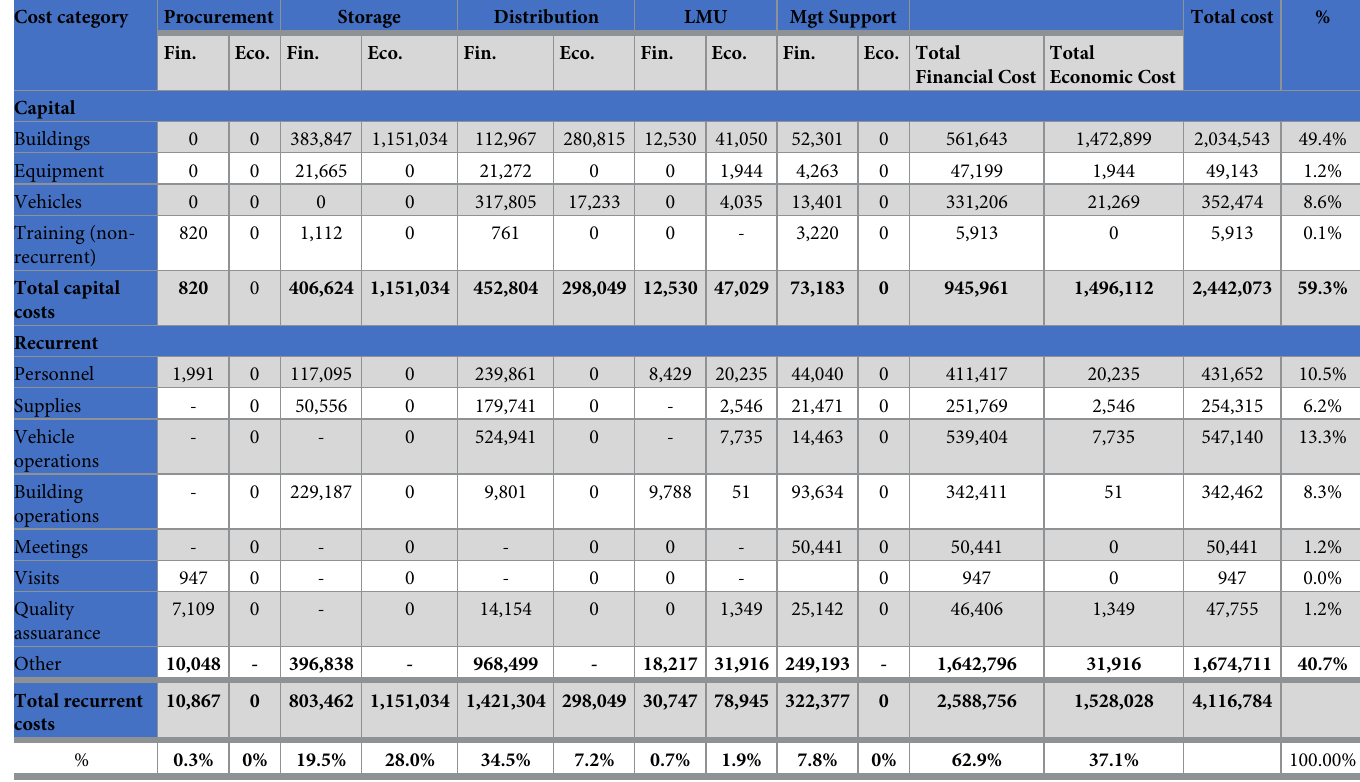
Table 3. The average annual costs of running the supply chain at four sampled zonal medical stores department by supply chain functions (2020 US$) (N = 4).